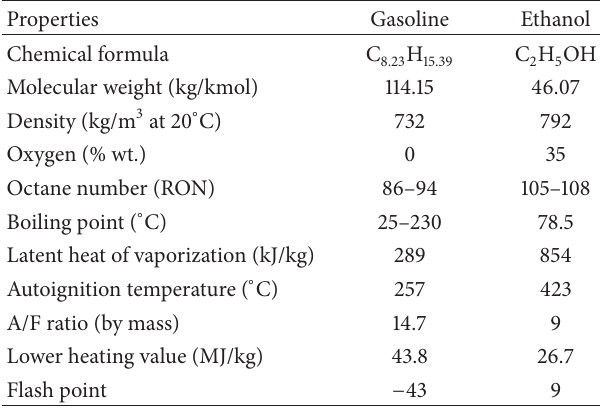
Table 2: Test fuel properties.